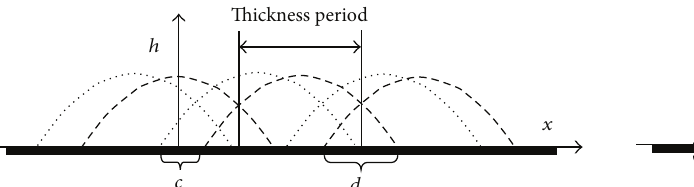
Figure 9: Coating thickness distribution when 0.5𝑑 < 𝑐 ≤ 𝑑 , 𝑐+𝑑 > 0.5 and 𝑐 + 2𝑑 ≤ 1 .